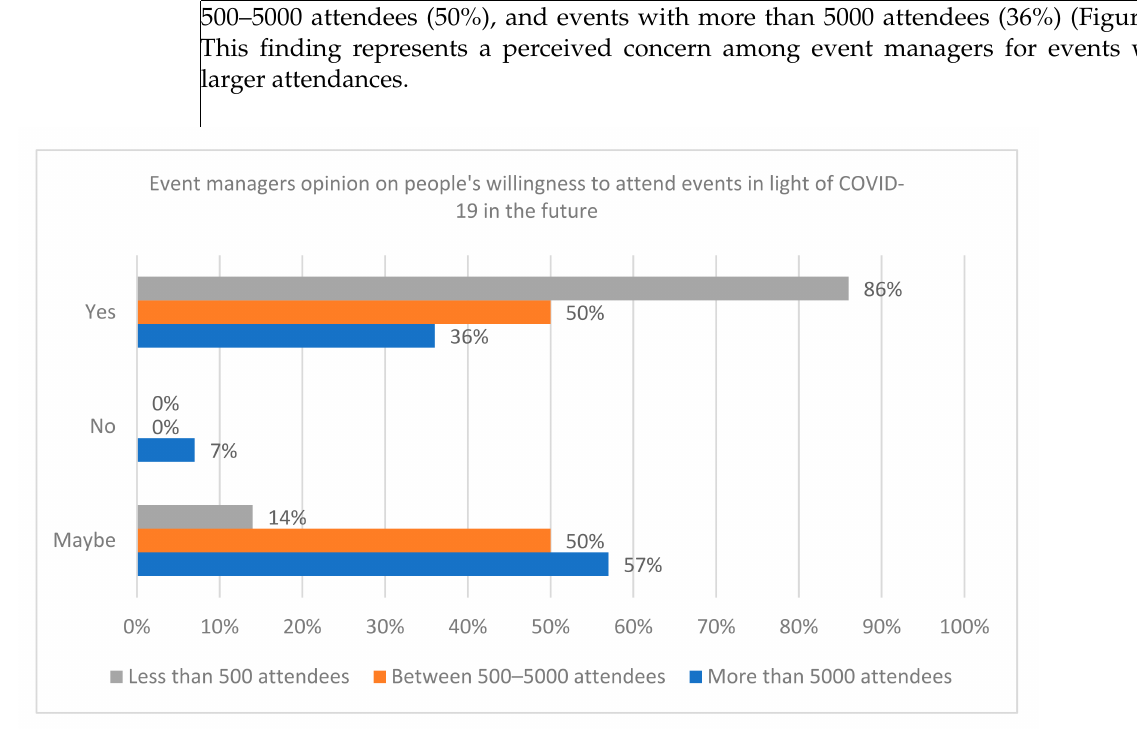
Figure 6. Event managers’ opinions on people’s willingness to attend events in light of COVID-19 in the future ( n =